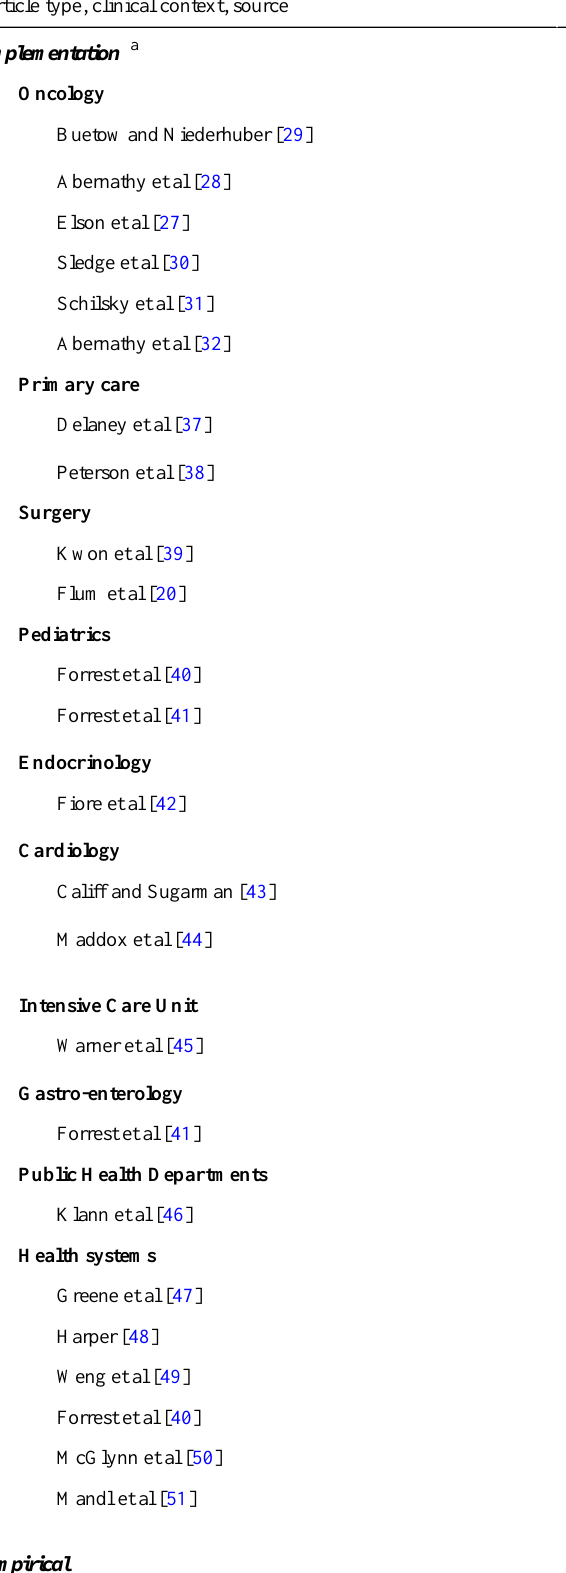
ClassificationName or focus of initiativeArticle type, clinical context,